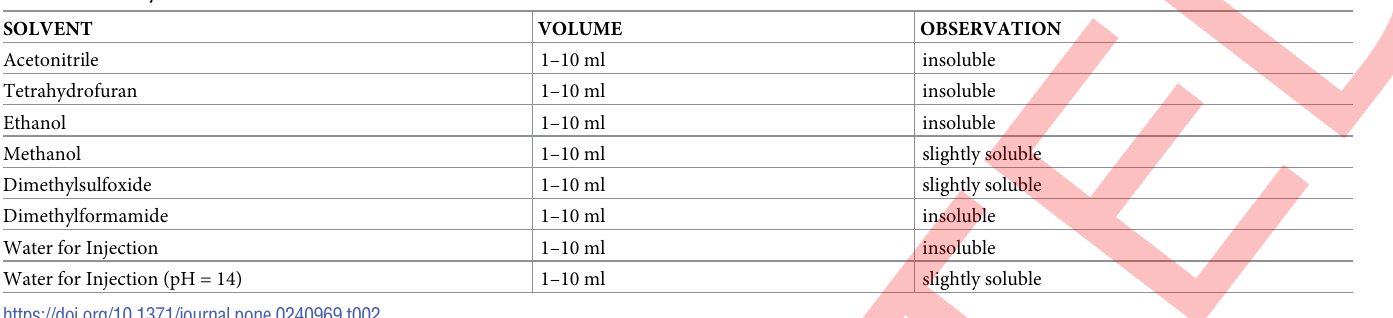
Table 2. Solubility test